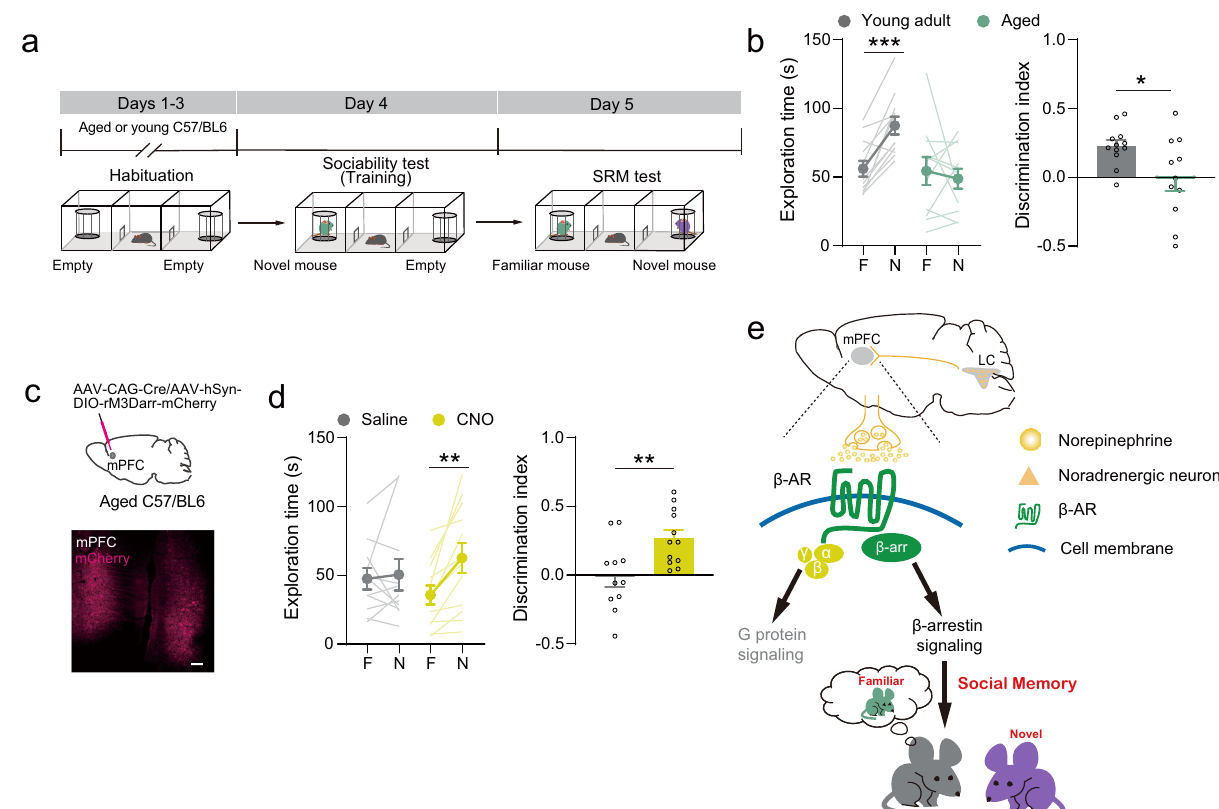
Fig. 6 Pharmacological activation of β -arrestin biased signaling improved SRM consolidation in aged mice. a Experimental scheme. SRM task was carried out in aged mice (>18 months old). b Statistical graphs of exploration time and discrimination scores [Young adult, n = 12; Aged, n = 11. Left: F = 9.816, p = 0.005, two-way RM ANOVA; Right: Z = 33.000, p = 0.045, Mann – Whitney U -test]. c Representative image of rM3Darr- mouse × age (1, 21) mCherry expression in the mPFC. AAV 9 -hSyn-DIO-rM3Darr-mCherry and AAV 9 -CAG-Cre were injected into the mPFC of aged mice (>18 months old). d Statistical graphs of exploration time for the familiar (F) and novel (N) mice and discrimination scores [Saline, n = 11; CNO, n = 12. Left: F mouse × treatment (1, 21) = 4.979, p = 0.037, two-way RM ANOVA, Right: t (21) = − 2.95, p = 0.008, two-tailed Student ’ s t test]. e Working model illustrating that LC-mPFC NE projections regulate memory consolidation of social recognition through β -arrestin2-biased signaling. * p < 0.05, ** p < 0.01 and *** p < 0.001 vs indicated group. Scale bar: 100 μ